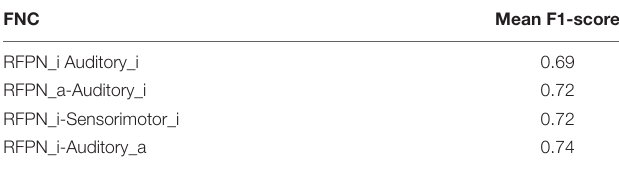
TABLE 3 | Best classification performance of a single